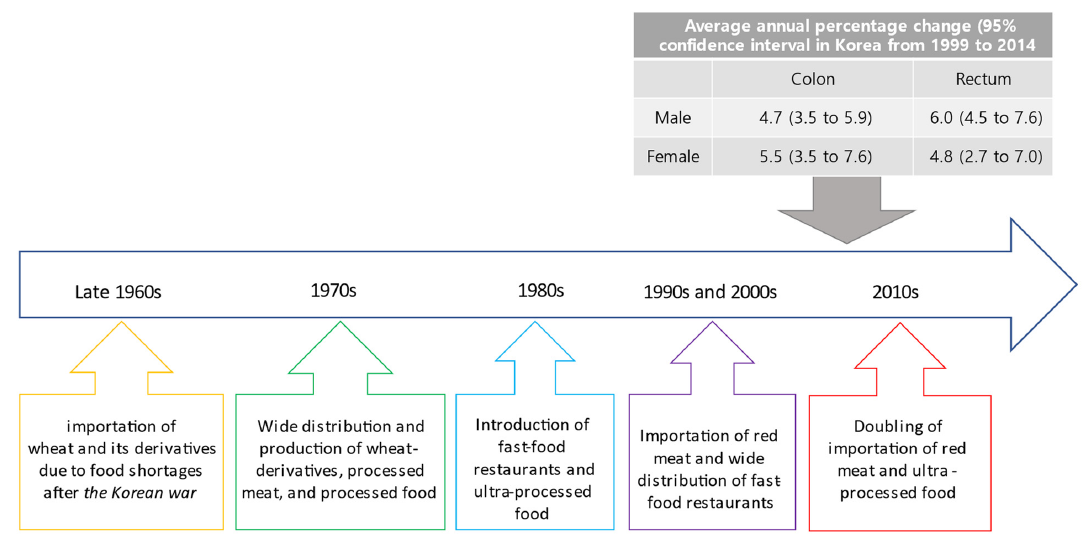
Figure 4. Dietary transition and the incidence of early-onset colorectal Figure 4 . Dietary transition and the incidence of early ‐ onset colorectal cancer.